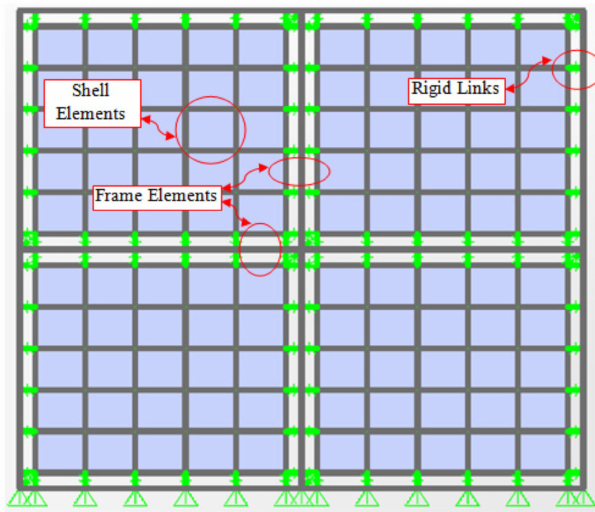
Figure 6. Homogenous shell finite element model of H-building